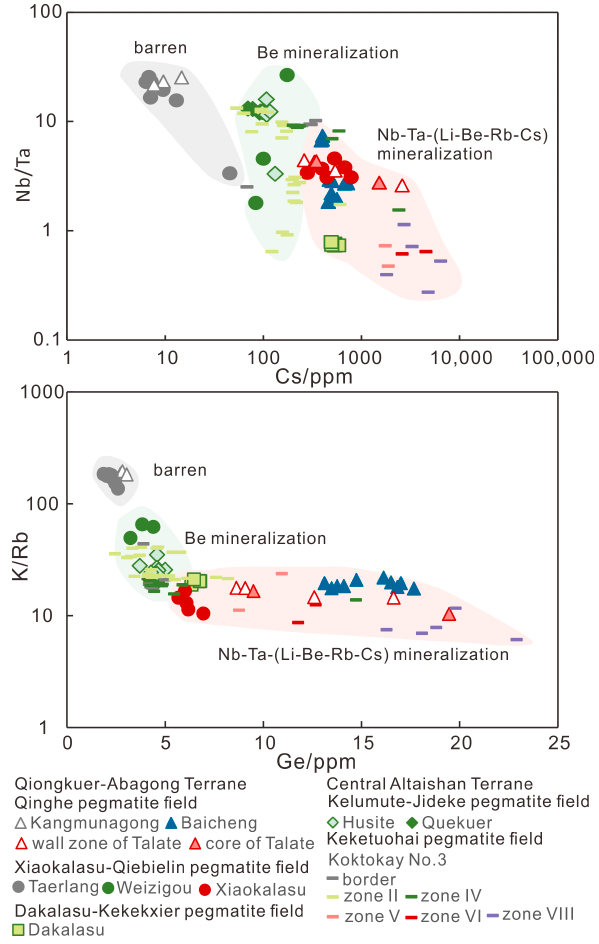
Figure 8. Variation diagrams of Nb/Ta vs. Cs content and K/Rb vs. Ge content, indicating the differences of muscovites from the barren, Be and Nb-Ta-bearing pegmatites in the Chinese Altai. The regions of zones I–IV and zones V–VIII of the Koktokay No.3 pegmatite are based on the data from